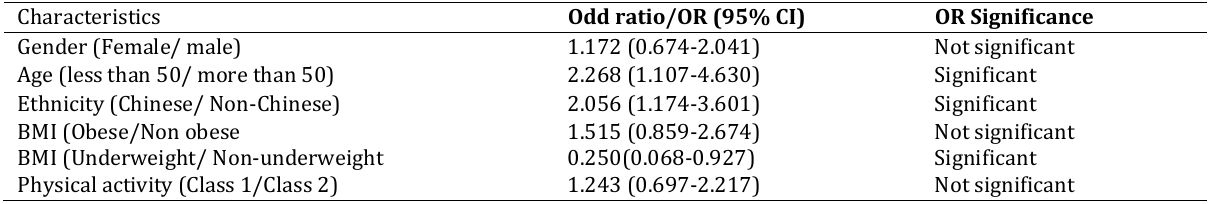
Table 2. Odd Ratio between Hemorrhoids and without Hemorrhoids